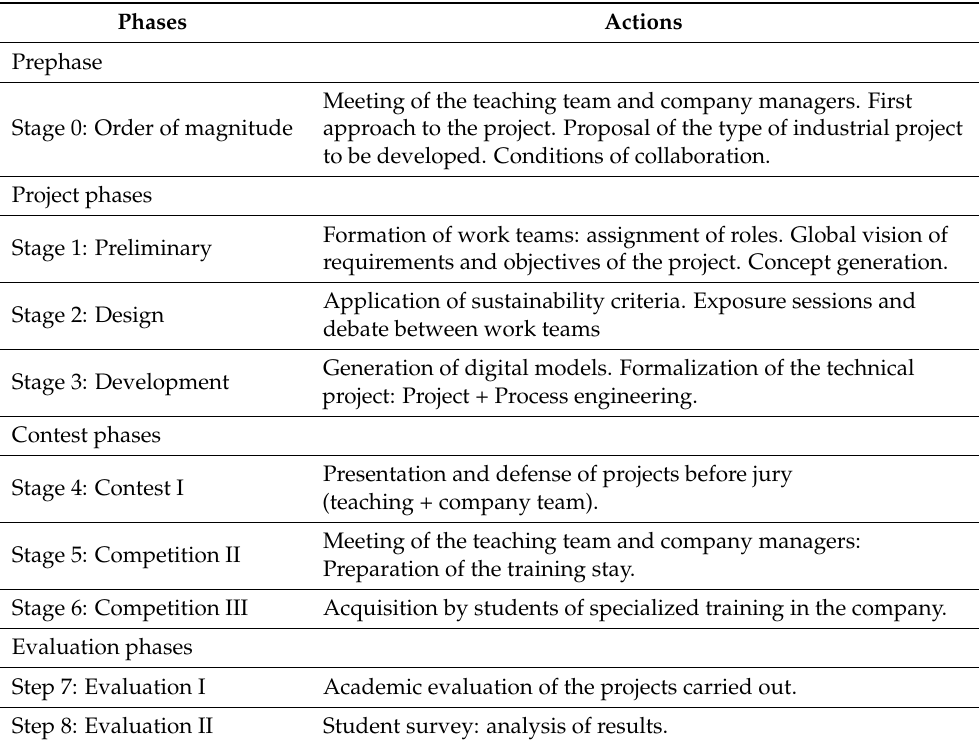
Table 2. Project development in technical project subject: phases, stages and